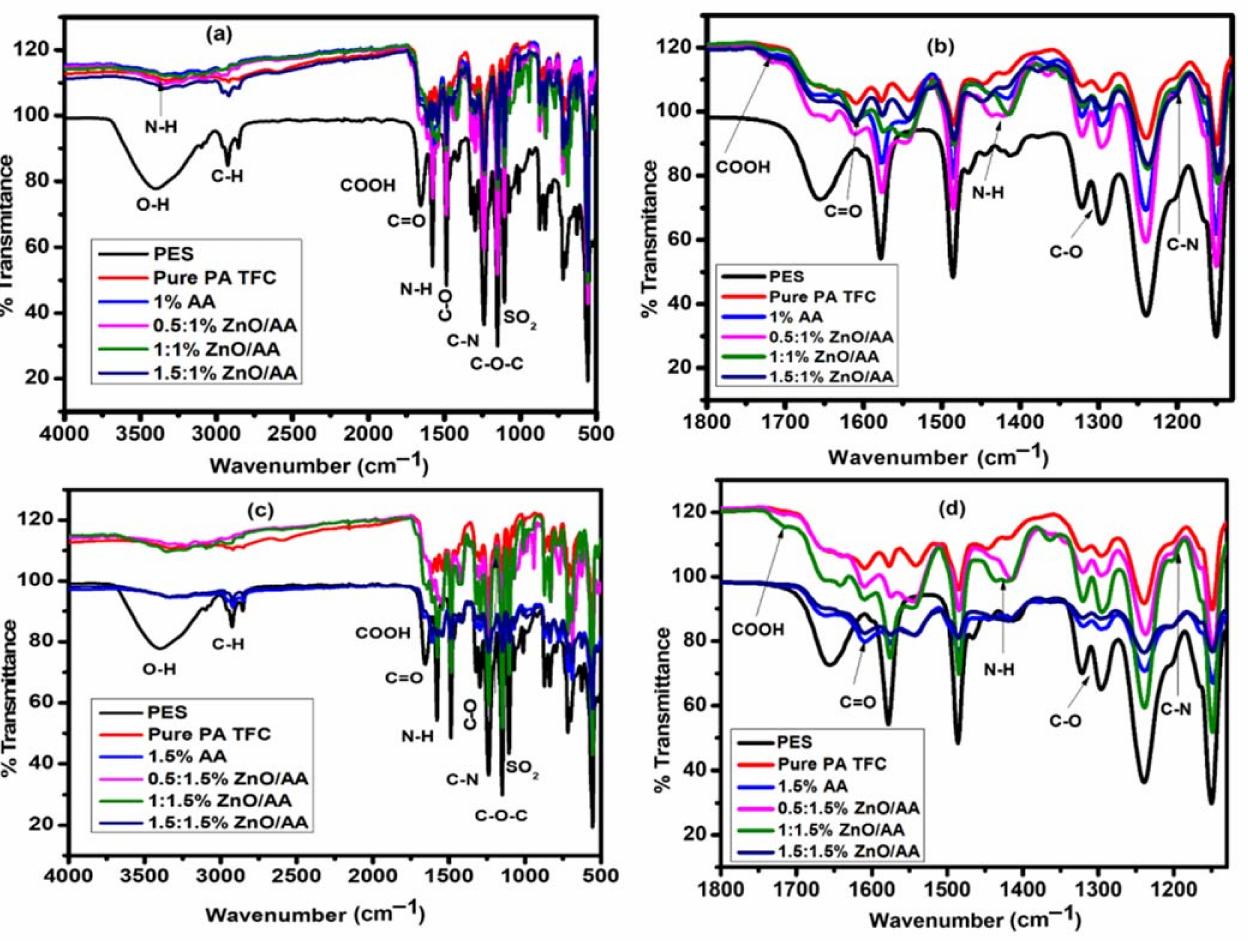
Figure 2. ( a ) ATR–FTIR spectra showing membranes modified with 0.00% AA (unmodified PA–TFC membrane), 1.00% AA, 0.50:1.00% ZnO/AA, 1.00:1.00% ZnO/AA, and 1.50:1.00% ZnO/AA. ( b ) Expanded spectra of (a) between 1800–1130 cm − 1 . ( c ) Membranes modified with 1.50% AA, 0.50:1.50% ZnO/AA, 1.00:1.50% ZnO/AA, and 1.50:1.50% ZnO/AA. ( d ) Expanded spectra of ( c ) between 1800–1130 cm − 1